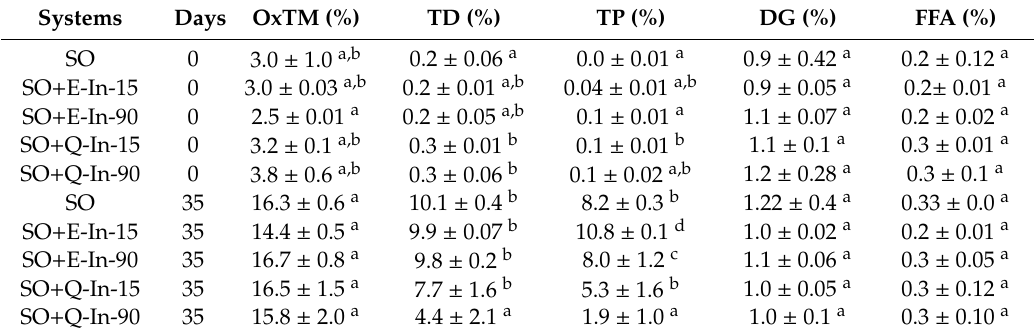
Table 3. Distribution of polar compounds (PC) for SO with and without amorphous or semi-crystalline flavonoid microparticles (200 mg / kg SO), at day 0 and after 35 days of storage at 60 ◦ C. Systems Days OxTM (%) SO